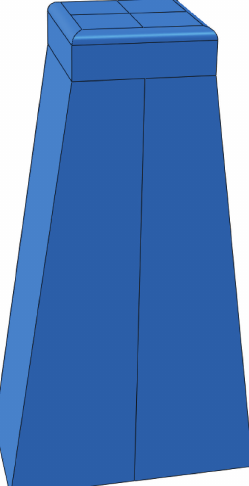
Figure 4: Geometry of the 6 × 6 inch impact face impactor used in the hazmat tank car impact numerical